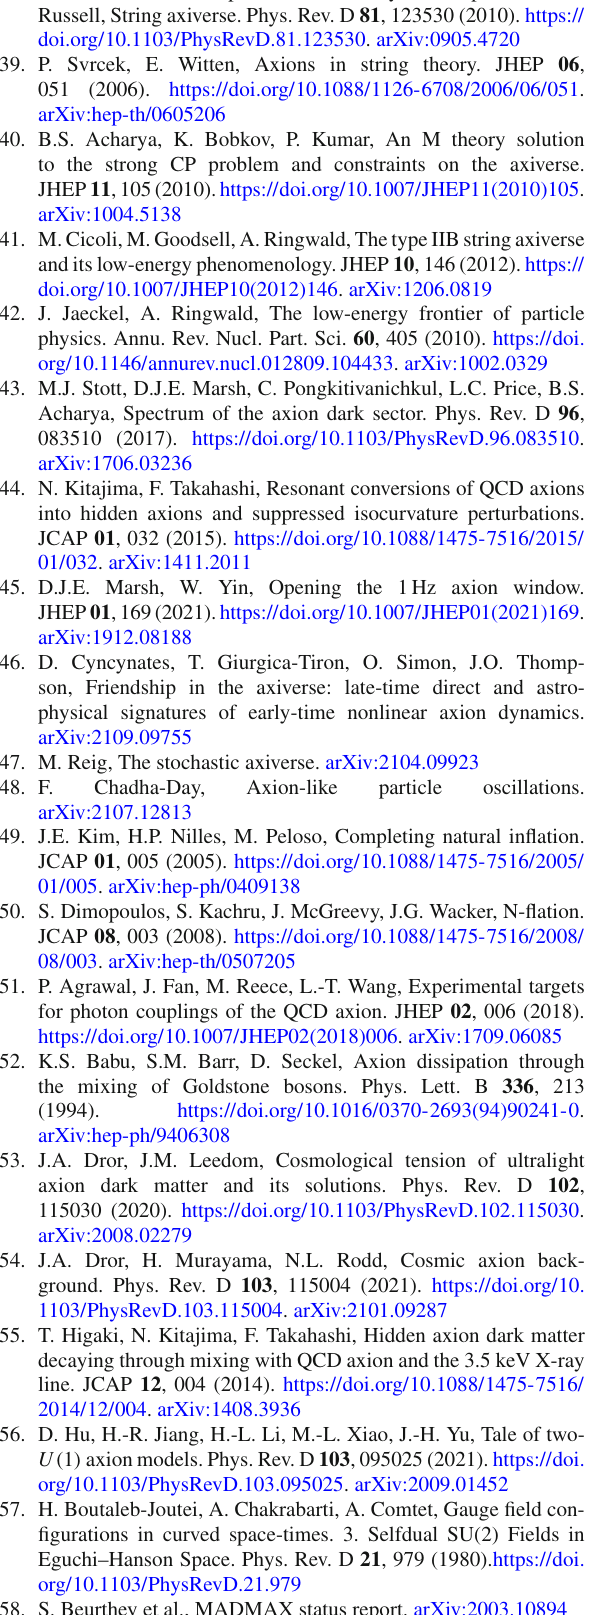
figurations in curved space-times. 3. Selfdual SU(2) Fields in Eguchi–Hanson Space. Phys. Rev. D 21 , 979